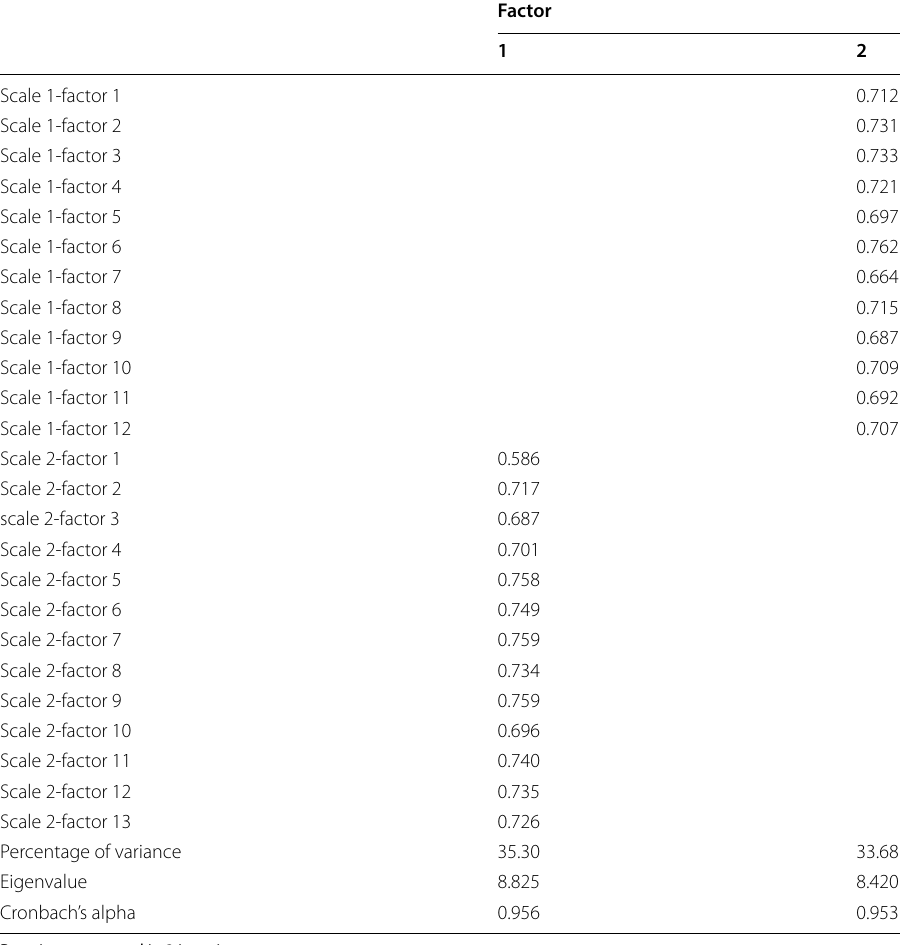
Rotation converged in 3